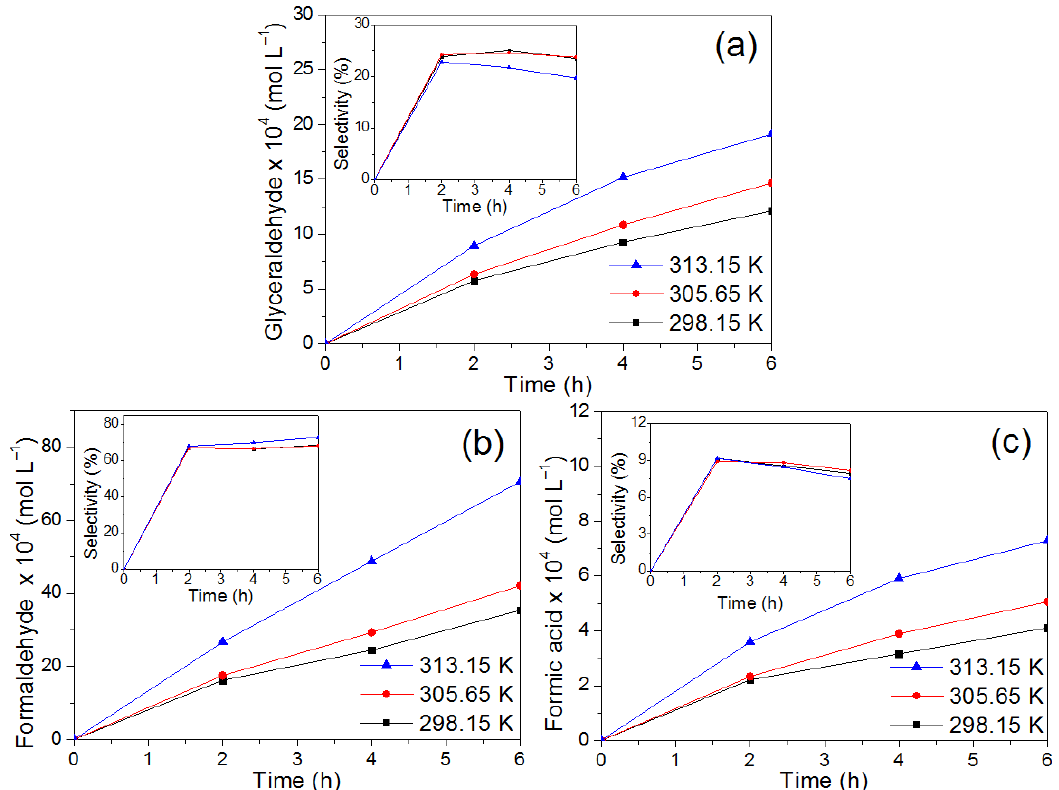
Figure 11. Effect of reaction temperature on concentration and selectivity towards ( a ) glyceralde- hyde (GCD), ( b ) formaldehyde (FD), and ( c ) formic acid (FA). Initial glycerol = 6.25 × 10 −2 M, Cu/TiO 2 = 0.25 g/L.